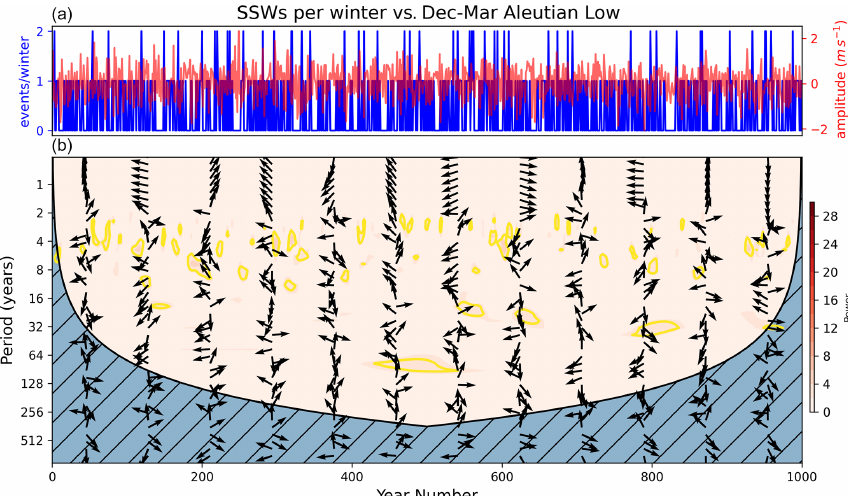
Figure A7. (a) December–March Aleutian Low index (red) and SSWs per NH winter (blue) time series. (b) Cross-wavelet power spectrum between the two time series.